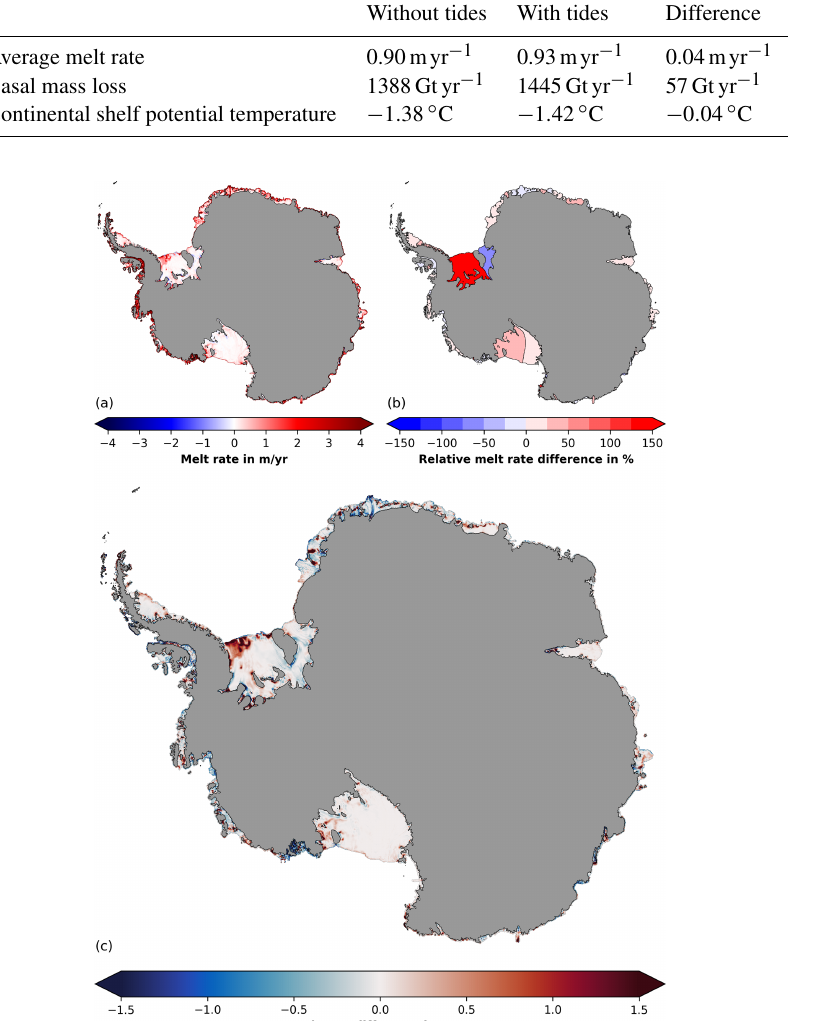
Figure 2. Tidal melting of Antarctic ice shelves. (a) Annual-averaged ice shelf melting for the case with tides, (b) its relative difference to the case without tides averaged over individual ice shelves ( ( Tides − No-Tides )/ No-Tides) and (c) its absolute difference to the case without tides (Tides −